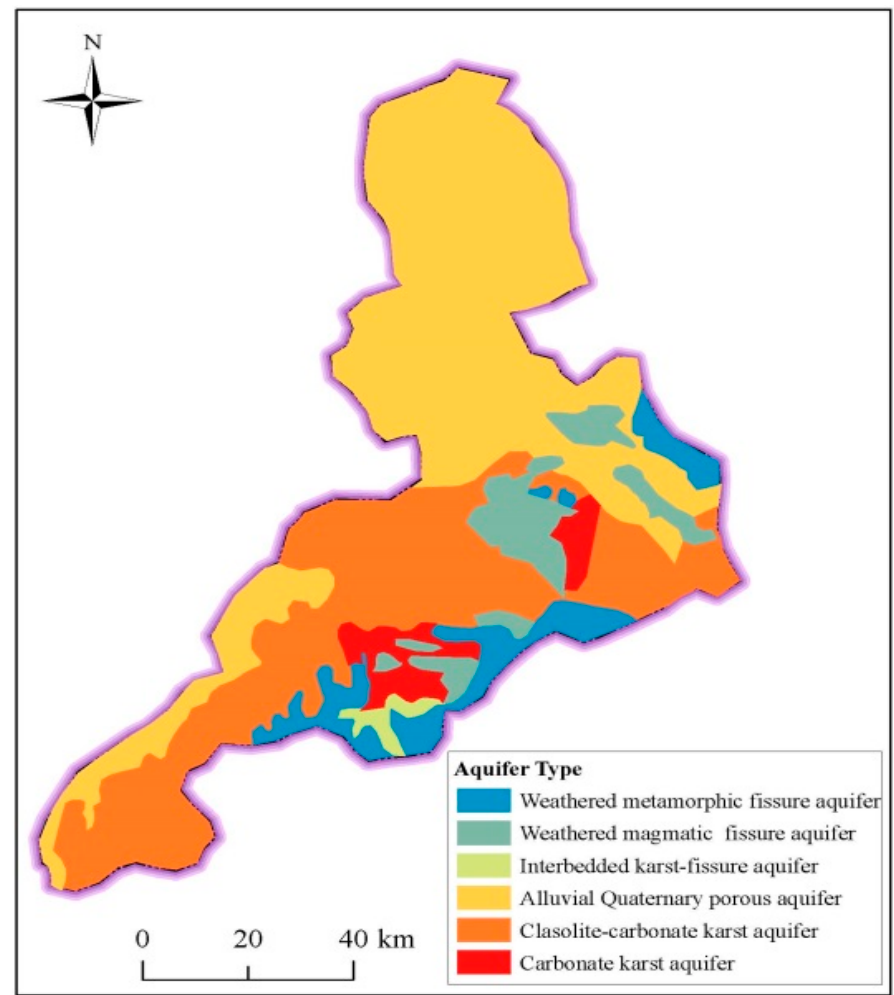
Figure 6. Spatial distribution of aquifer types in Jinan.